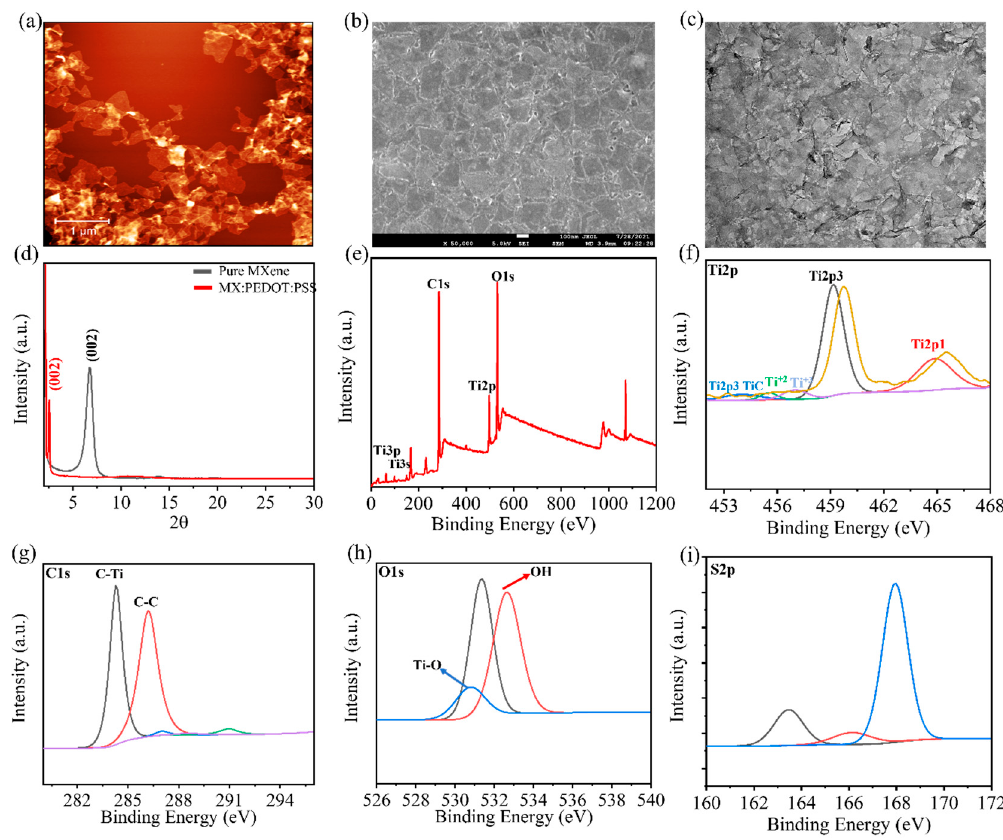
Figure 2. ( a ) AFM and ( b ) SEM images of well-distributed Ti 3 C 2 T x nanosheets, and ( c ) TEM image of Ti 3 C 2 T x nanosheets; ( d ) XRD patterns of pure Ti 3 C 2 T x and Ti 3 C 2 T x -doped PEDOT:PSS; ( e ) XPS spectral survey of Ti 3 C 2 T x -doped PEDOT:PSS, and high-resolution XPS spectra of ( f ) Ti2p, ( g ) C1s, ( h ) O1s, and ( i ) S2p.